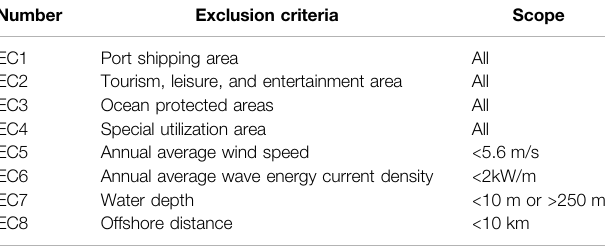
TABLE 1 | Exclusion criteria for COWWF siting in Zhejiang